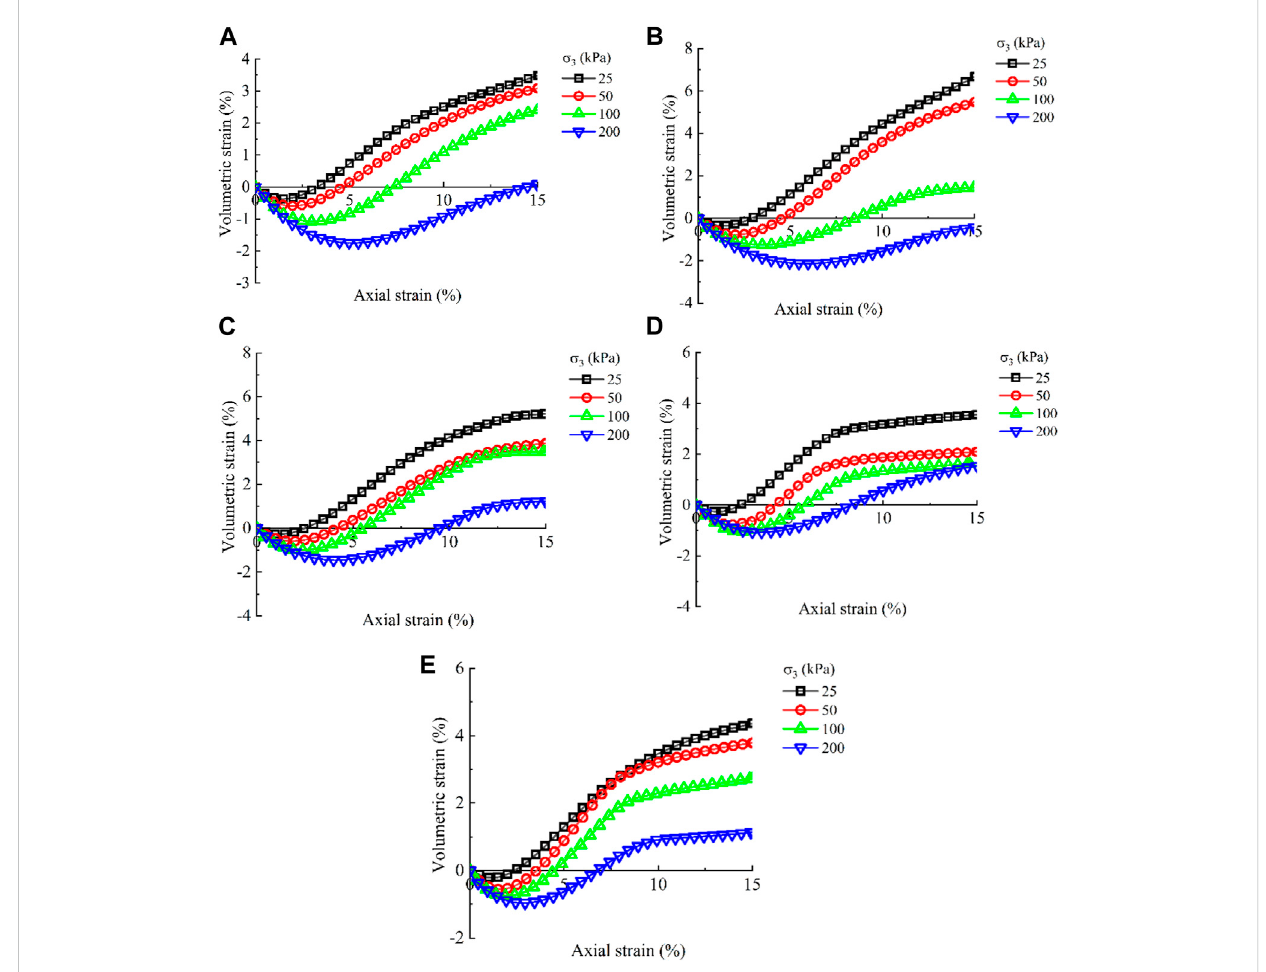
FIGURE 4 Volumetric strain – axial strain curve of calcareous sand. (A) Calcareous gravel sand. (B) Calcareous coarse sand. (C) Calcareous medium sand. (D) Calcareous fi ne sand. (E) Calcareous